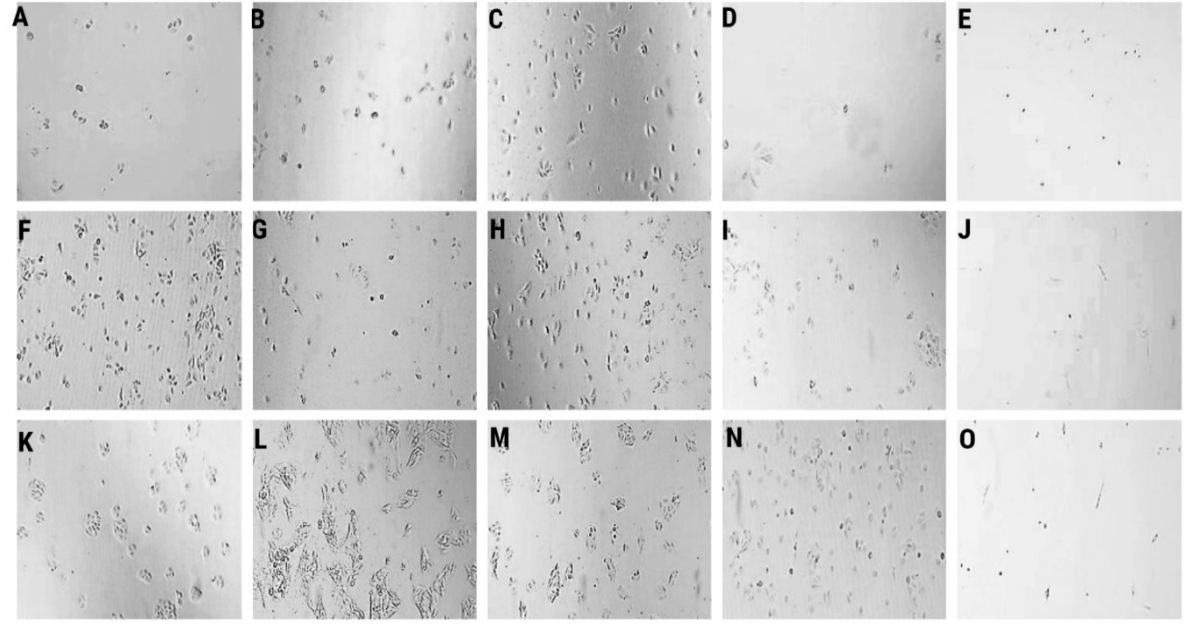
Figure 1. Representative microscopy images of the colony formation assays are shown. Clonogenic capability of human glioma U251 cells over 1 day in control ( A ), LL-37 (4.0 µ M) ( B ), PG-1 (16.0 µ M) ( C ), NGF (7.55 × 10 − 3 µ M) ( D ), TMZ (155 µ M) ( E ), over 2 day in control ( F ), LL-37 (4.0 µ M) ( G ), PG-1 (16.0 µ M) ( H ), NGF (7.55 × 10 − 3 µ M) ( I ), TMZ (155 µ M) ( J ), over 3 day in control ( K ), LL-37 (4.0 µ M) ( L ), PG-1 (16.0 µ M) ( M ), NGF (7.55 × 10 − 3 µ M) ( N ), TMZ (155 µ M) ( O ). Lens magnification ×10.